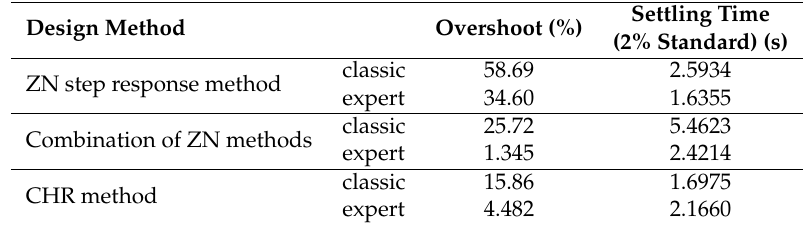
Table 2. Overshoot and settling time in percent of step response of controlled system with parameters a 2 = 3, a 1 = 12 and a 0 = 15